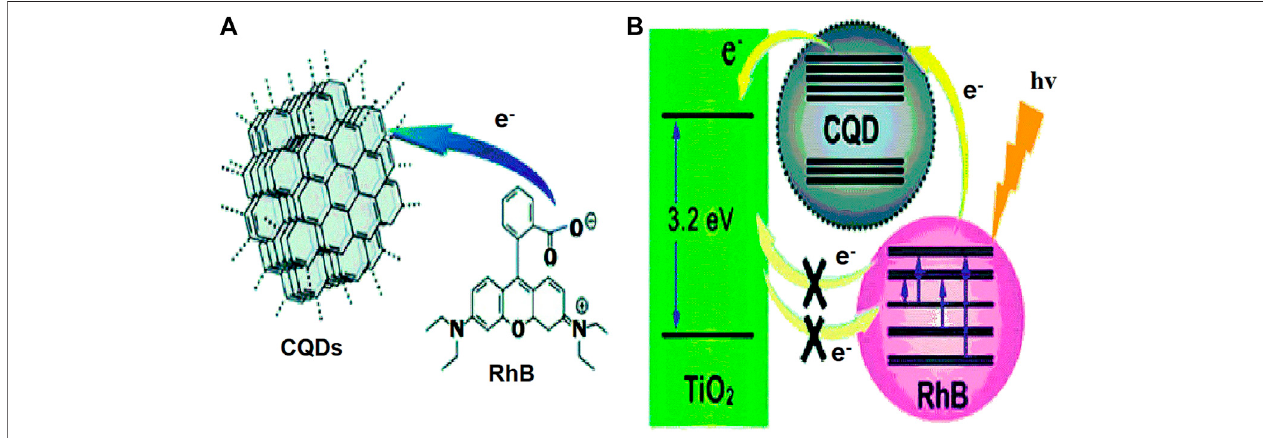
FIGURE 16 | (A) Scheme of electron transfer to CQDs from RhB. (B) The CQDs work as an electron transfer mediator. Reprinted with the permission from (Wang and Hu, 2014).